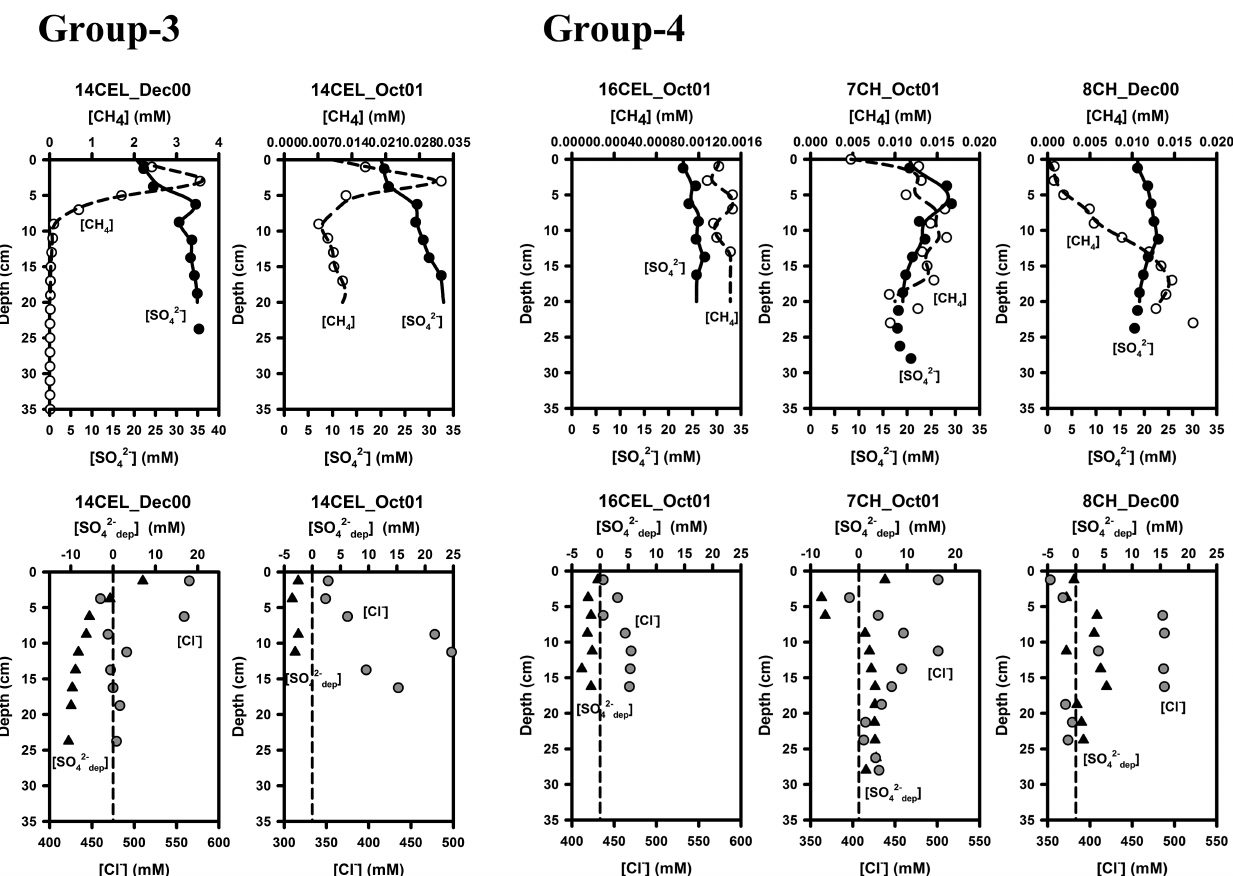
Figure A1. Depth profiles of modeled (lines), measured (circles) and calculated (triangles) concentration of dissolved methane (dashed lines; open circles), sulfate (solid lines; solid circles) in the upper panel and sulfate depletion (solid lines; solid triangles), zero sulfate depletion (dashed lines) and chloride (gray circles) in the lower panel for each profile type (Groups 1–4, see text). One selected profile per group is shown in Fig. 2 for illustration and here the other profiles are shown (9 cores for Group-1, 6 cores for Group-2, 2 cores for Group-3 and 3 cores for Group-4). CEL and CH represent cores collected from Celestún Lagoon and Chelem